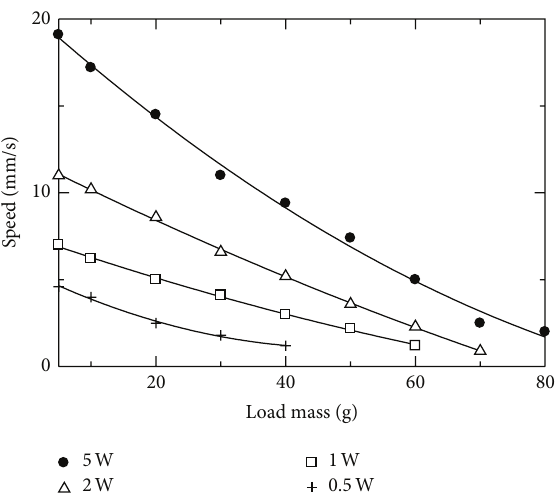
Figure 6: Relationship between input power and speed when the attractive force was set to 0.65 N.